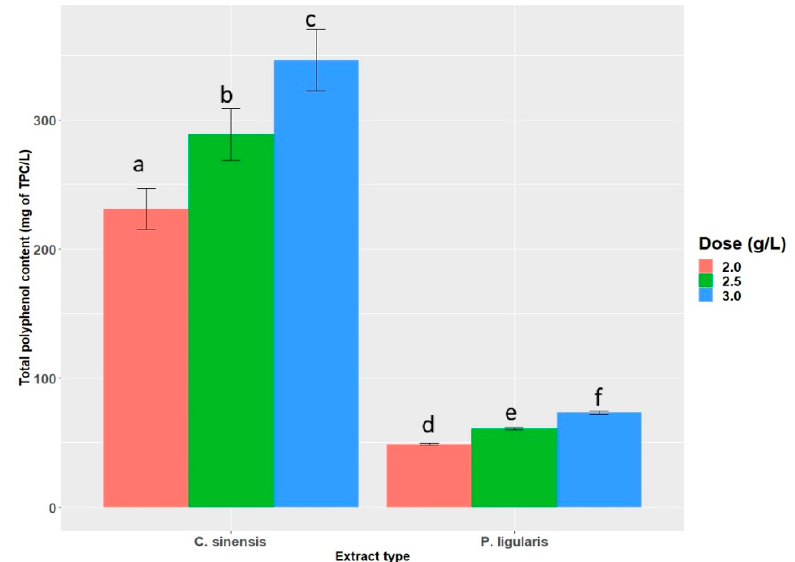
Figure 2. Total polyphenol content from both sources in each dose (mg of TPC/L of solution). Data are means (±standard deviations). Columns with different lowercase letters show statistically significant differences between them by the Duncan test ( p < 0.05).